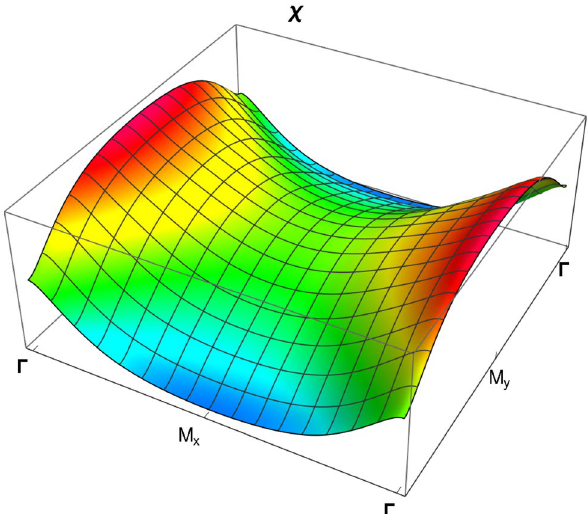
Fig. 2 The hybridization function 𝜒 𝐩 = S p D p representing the amplitude electron from conduction Cu3 d x 2 − y 2 band being simulta- neously a Cu4 s electron. This is the main ingredient of the matrix elements of the s-d exchange interaction